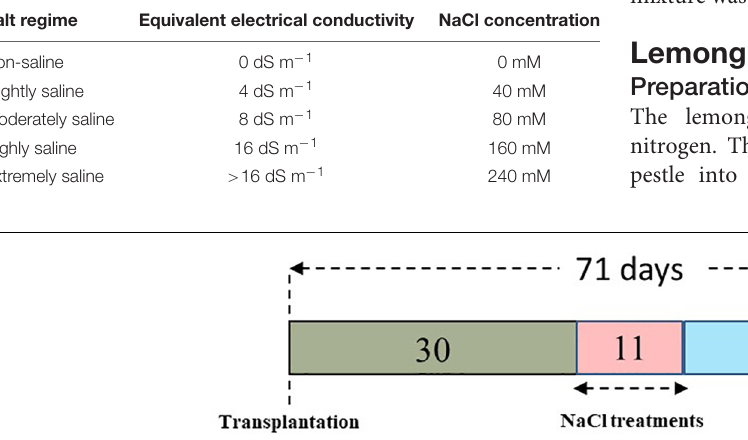
TABLE 1 | Different salt regimes generated during the present experiment for assessing salt tolerance in lemongrass.